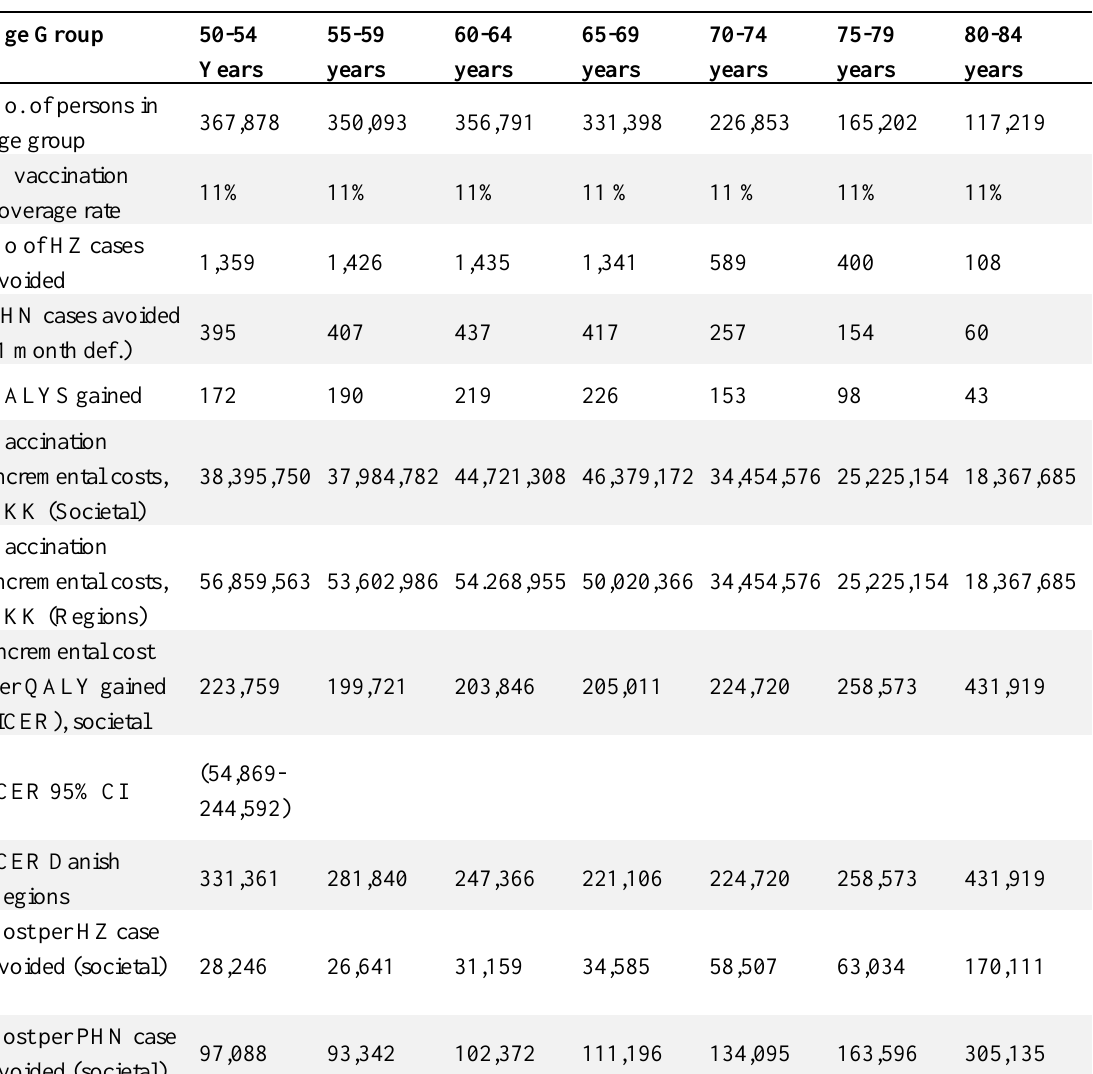
Table 8: Results by age group: Number of cases avoided with vaccination, QALYs gained, costs, incremental cost-effectiveness, and 95% CI, by age group, (costs in DKK 2011